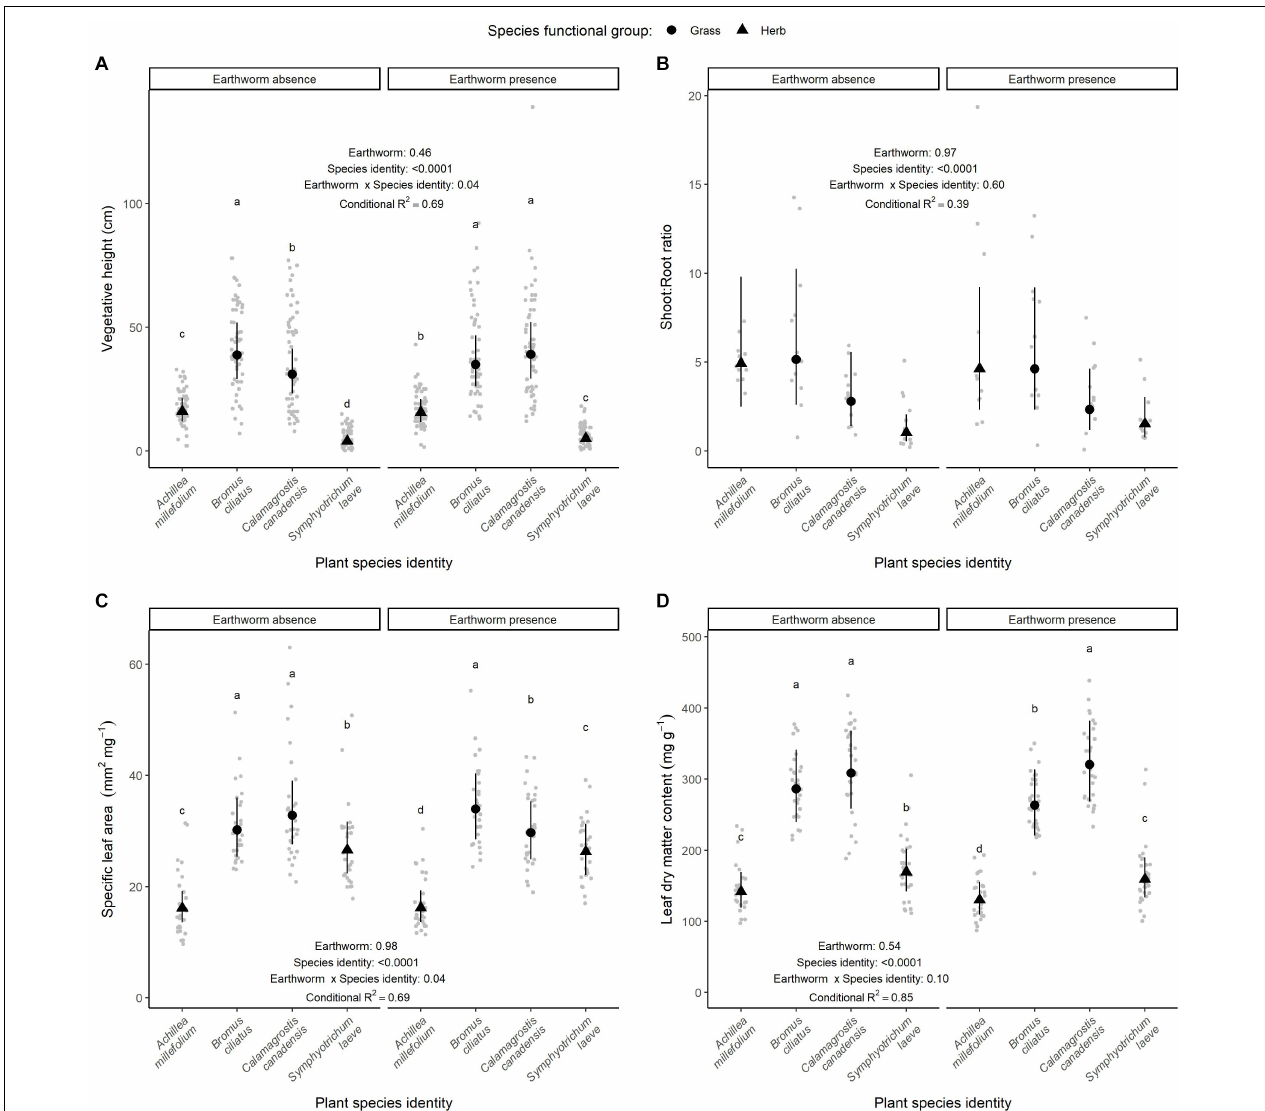
FIGURE 3 | Effect of earthworm presence on plant height (A) , shoot:root ratio (B) , specific leaf area (C) , and leaf dry matter content (D) . Estimated marginal means and confidence intervals are shown in black (after being back-transformed), while data points were included in the background in gray. The conditional R 2 as well as the p -values for each factor are based on linear mixed effect models. When the interaction between earthworm treatment and species identity were significant, post hoc test results are also presented: different letters show significant differences among species within each earthworm treatment. Number of observations per species and treatment: 60 for height; 30 for SLA and LDMC, and 12 for the shoot:root